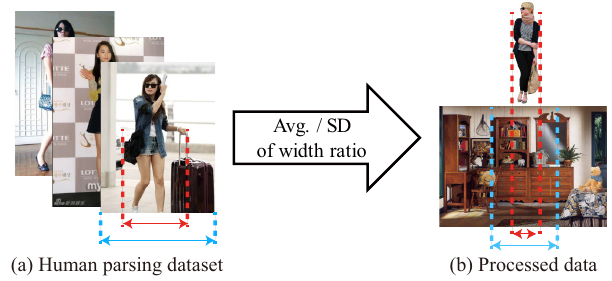
Fig. 3 Details of background image